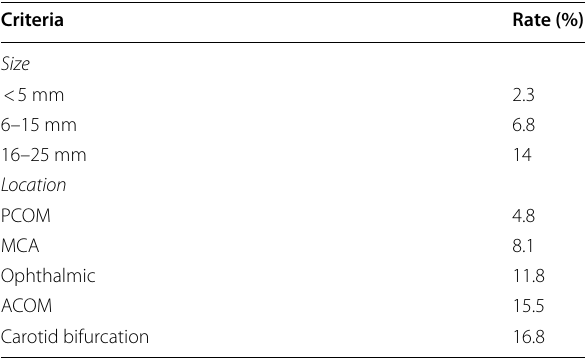
PCOM posterior communicating artery, MCA middle cerebral artery, ACOM anterior communicating